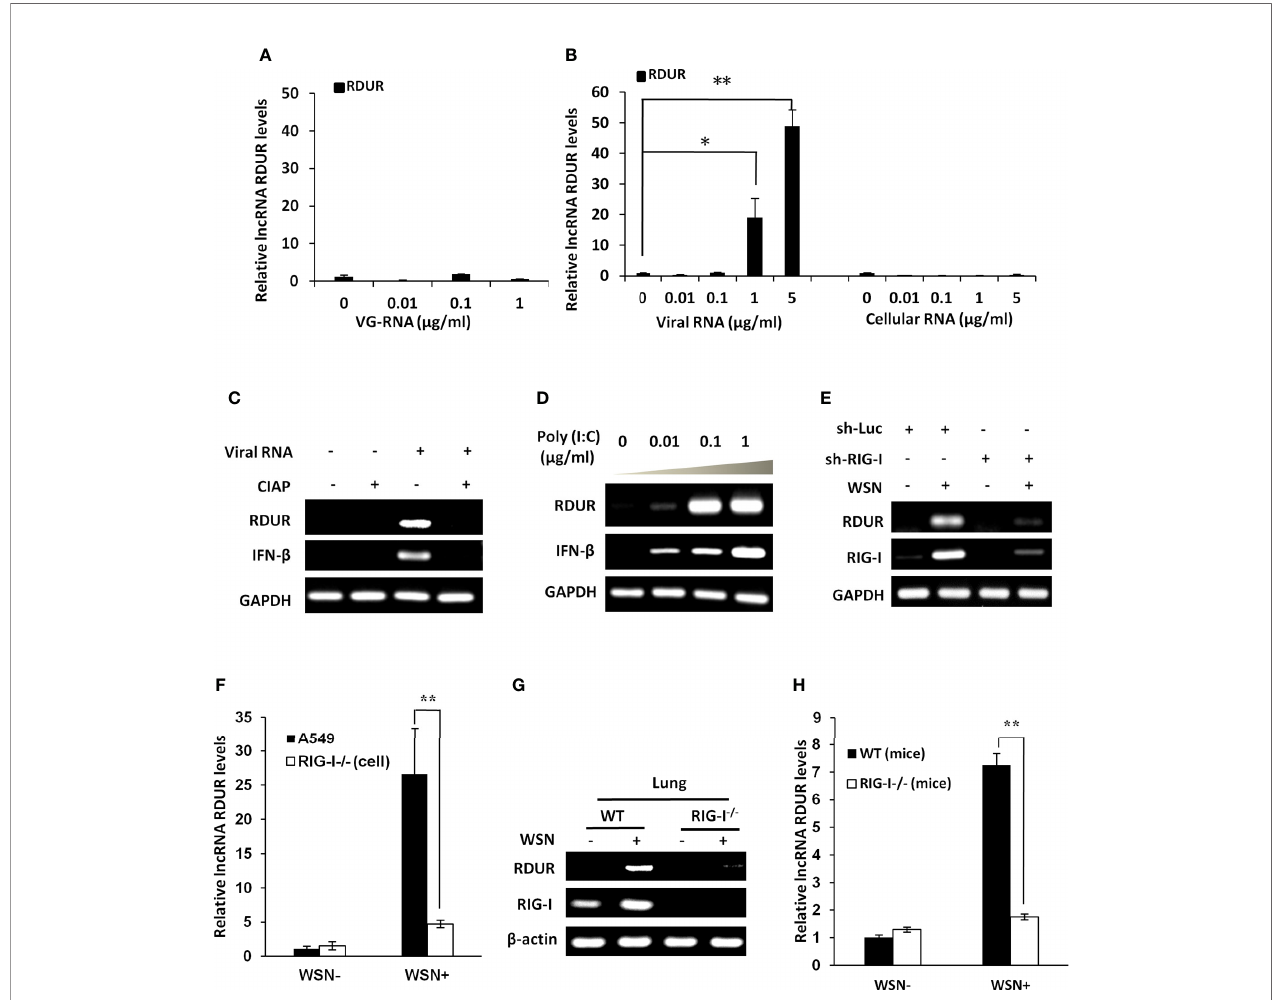
FIGURE 3 | IAV-induced robust expression of RDUR is RIG-I dependent both in vitro and in vivo . (A) A549 cells were transfected with indicated amount of WSN genomic RNA (VG-RNA) using Lipofectamine 2000. Effect of VG-RNA on the expression of RDUR was determined by qRT-PCR. (B) Different amounts of total RNA from A549 cells infected with (named as Viral RNA) or without (named as Cellular RNA) WSN virus were transfected into native A549 cells respectively using Lipofectamine 2000. Expression of RDUR in transfected A549 cells was examined by qRT-PCR. (C) Viral RNA from IAV-infected A549 cells was treated with/without alkaline phosphatase calf intestinal (CIAP), and was transfected into native A549 cells. Expression of RDUR in A549 cells was then examined by RT-PCR. (D) Different amounts of poly (I:C) were transfected into A549 cells and expression of RDUR in transfected A549 cells was examined by RT-PCR. (E) A549 cell line stably expressing shRNAs targeting RIG-I was generated. Then, the cells were infected with WSN for 16 h, and the expression of RDUR was examined by RT-PCR. (F) RIG-I knockout A549 cells were generated by utilizing CRISPR-Cas9. These cells and native A549 cells were infected with WSN for 16 h, and the expression of RDUR was examined by qRT-PCR. (G, H) RIG-I knockout mice were infected with WSN for 1 day, and the expression of RDUR in lungs was detected by RT-PCR (G) and qRT-PCR (H) . Shown are representative data from three independent experiments. The error bars represent the SD, * P < 0.05, ** P <